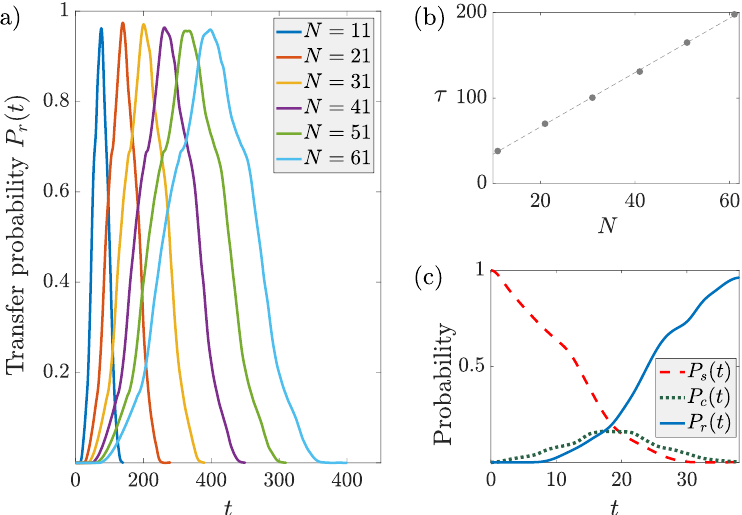
Figure 4: Excitation transfer via static couplings of the sender and receiver spins with (cid:112) = 0.49 J / N to the chain of N spins with long-range exchange interactions rates J s , r ( t ) vs time t (in units of 1 / J ) for different and no disorder. (a) Transfer probability P r chain lengths N . The energies of the sender and receiver spins ε are tuned to the s , r energy of the eigenstate of the chain closest to E = − 0.22 J . (b) Transfer time τ (gray filled circles), corresponding to the first peak of the transfer probability in (a) for each chain length N . Dashed line shows the linear fit τ J = 3.2 N + 2.3. (c) Time-evolution ( t ) , receiver P ( t ) and intermediate of the excitation probability for the sender P s r ( t ) , for a chain of N = 11 chain P c